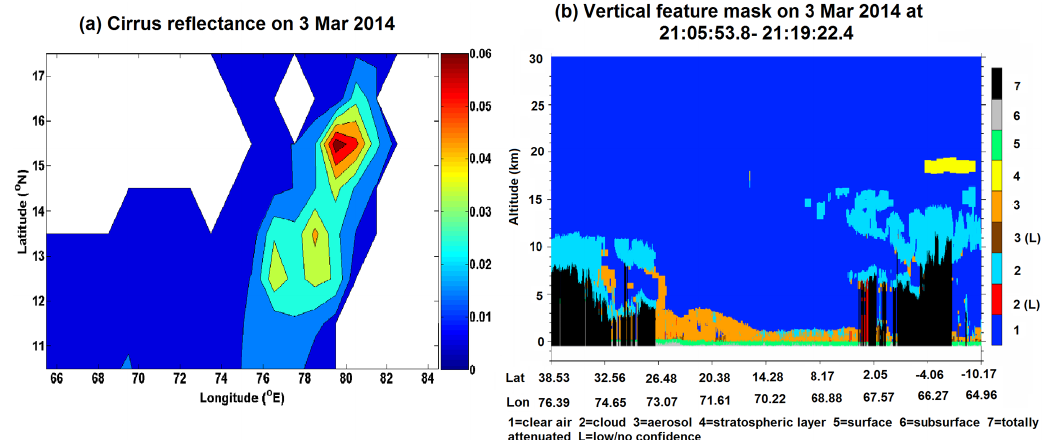
Figure 2. (a) Longitude–latitude cross section of cirrus reflectance on 3 March 2014 from MODIS Terra platform and (b) height variation of the vertical feature mask obtained from CALIPSO on its orbit track from 21:05 to 21:19UT on 3 March 2014. the Pacific and Atlantic sectors (Waugh and Polvani,